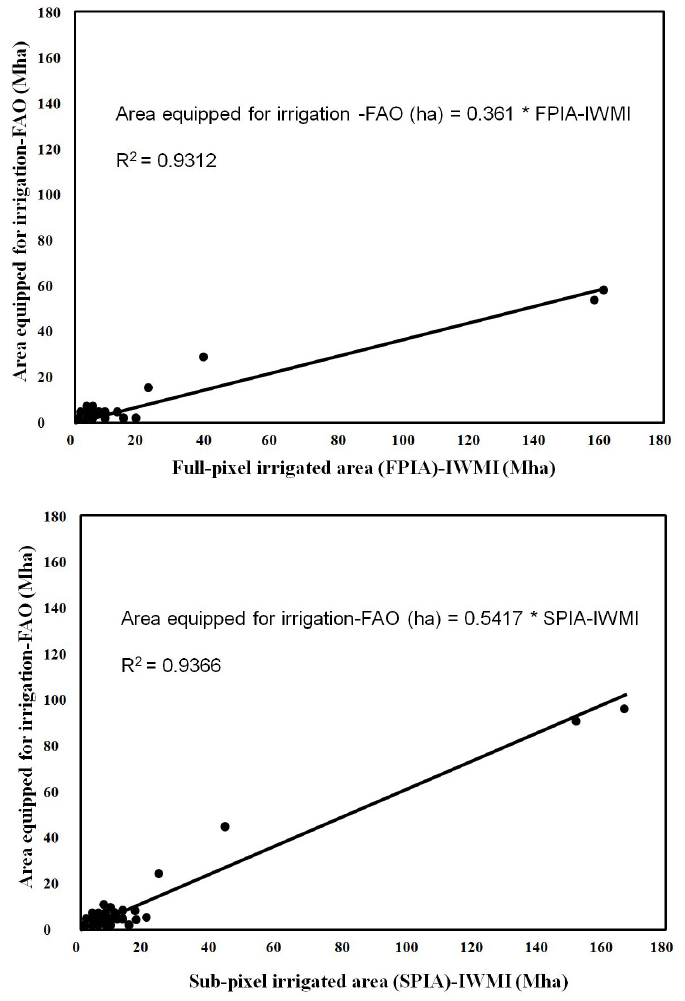
Figure 7. Actual irrigated areas from FAO Aquastat are plotted against FPIA (Figure 7a) and SPIA (Figure 7b) for 40 leading irrigated area countries which occupy nearly 95 % of all global